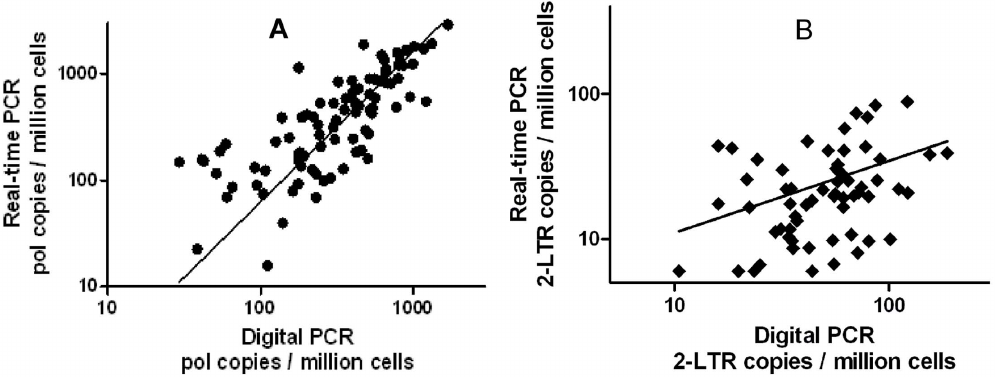
Figure 3. Correlation of ddPCR and qPCR measurements. ( a ) Pol copy numbers measured by ddPCR and qPCR were significantly correlated (Pearson R 2 =0.64, slope=0.98 6 0.08). The correlation weakened at low copy numbers, primarily due to a rapid increase in the variance of the qPCR assay (Fig. S3 (a)). For copy numbers measured in the bottom tertile ( , 230 HIV DNA copies/10 6 cells) by ddPCR, the correlation was not significant (R 2 =0.08, P=0.12). In the central tertile, the correlation was weak but significant (R 2 =0.15, P=0.03). In the top tertile, the correlation was strong (R 2 =0.53, P , 0.0001). ( b ) 2-LTR copy numbers measured by both methods were significantly but weakly (R 2 =0.14, P=0.002) correlated.